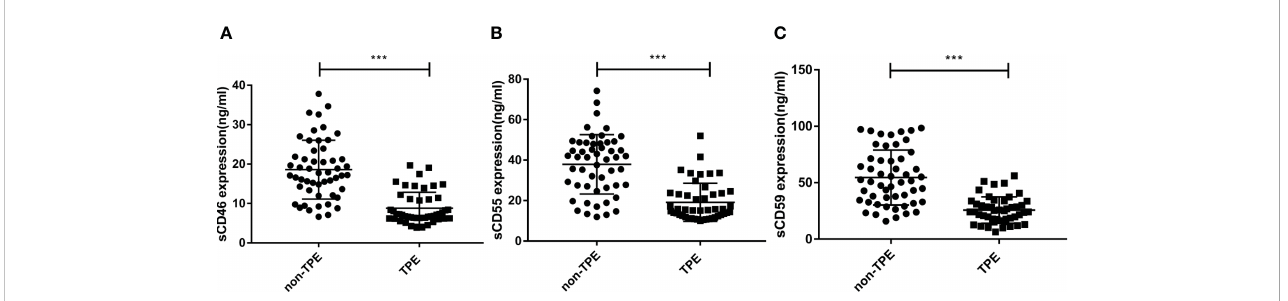
FIGURE 3 Concentration of sCD46, sCD55 and sCD59 in TPE (N=47) and non-TPE(N=52) patients. The level of sCD46, sCD55 and sCD59 in pleural effusion were detected by ELISA. Comparison ofsCD46 (A) , sCD55 (B) , sCD59 (C) level in TPE and those in non-TPE. ∗∗∗ P < 0.001.